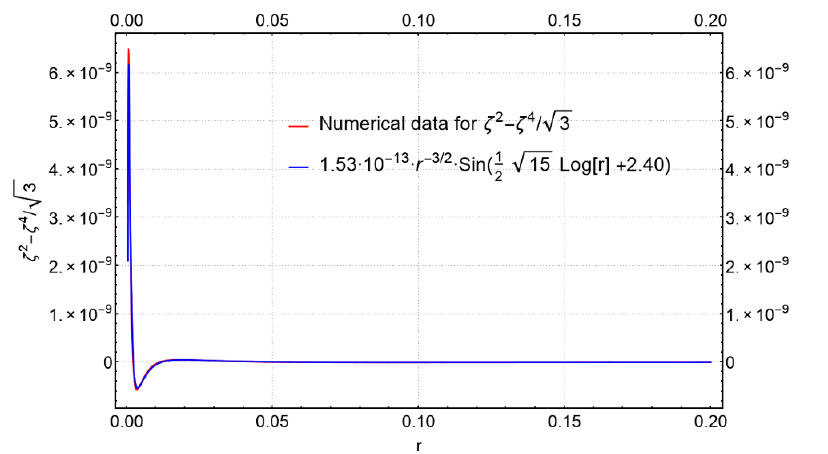
Figure 17 . The warp factor di(cid:11)erence ^ (cid:16) 2 (cid:0) ^ (cid:16) 4 = The value of the non-vanishing radius is ^ (cid:16) 4 (0) = ^ (cid:26) = 10 (cid:0) 5